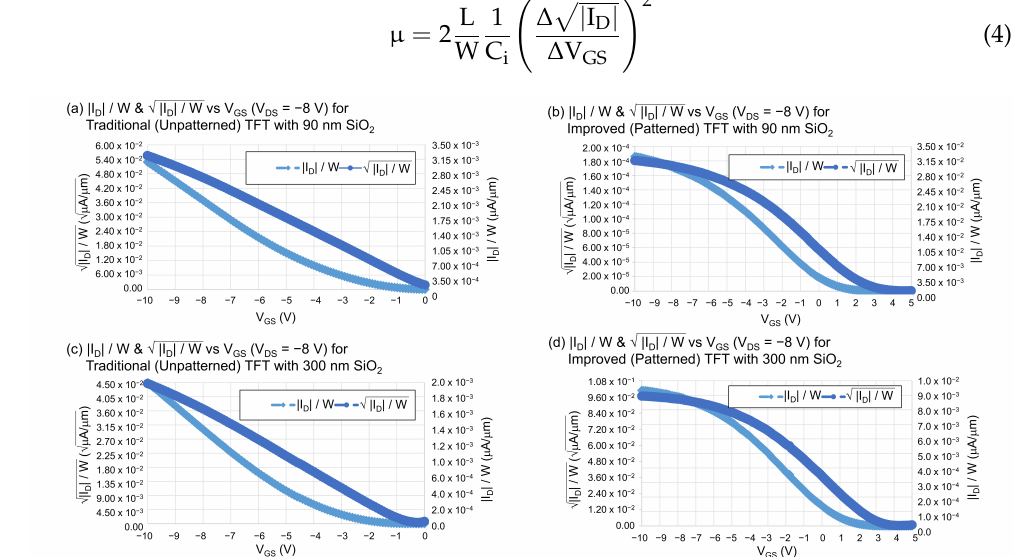
(cid:112) | Figure 7. The |I D |/W versus V GS (LIGHT BLUE) and I D | /W versus V GS (DARK BLUE) trans- fer characteristics, measured in the saturation regime (with V DS = − 8 V), for the: ( a ) traditional (unpatterned) TFT with 90 nm SiO 2 , ( b ) improved (patterned) TFT with 90 nm SiO 2 , ( c ) traditional (unpatterned) TFT with 300 nm SiO 2 , and ( d ) improved (patterned) TFT with 300 nm SiO 2 .